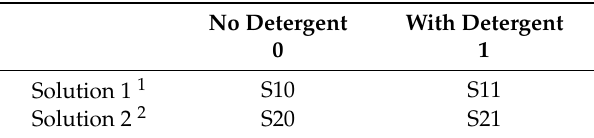
Table 1. Washing test conditions 3